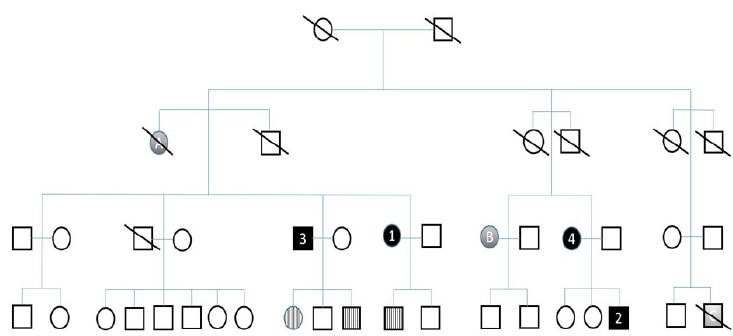
Figure 3. Pedigree of a family with frontotemporal dementia. Cross ‐ hatched symbols represents individuals who are no longer living. Black circles (females) and squares (males) represent individuals with dementia (1,2,3,4). Symbols with colour gradients represent patients with a positive history of dementia without genetic testing (A,B,C). Symptomless individuals who are mutation carriers are in the pattern 4. Discussion Proper clinical differentiation between fvAD and bvFTD has implications for prog ‐ nosis, treatment, and caregiver burden. Unfortunately, the clinical presentation in the course of bvFTD and fvAD can be very similar. FvAD is characterized by episodic memory impairment accompanied by behavioural and/or executive function deficits [6]. The clinical course of FvAD is less well defined, coming mainly from case reports. Our patients’ history and additional testing first suggested fvAD (dysexecutive type), but extended genetic testing eventually revealed another cause of dementia. After receiv ‐ ing the NGS results, we asked ourselves whether it was possible to make a correct clinical diagnosis based on the data available so far. Both patients did not meet the diagnostic criteria for bvFTD, which include a wide range of neuropsychiatric behaviours (disinhibited behavior, profound apathy, loss of em ‐ pathy, perseverative/compulsive behaviour, hyperorality or dietary changes) [9]. In both patients, the leading clinical feature was cognitive decline (episodic memory deficit, im ‐ paired learning of new information, and executive deficits). Atypical clinical presentation is more common in early ‐ onset AD (EOAD). Apathy, which was the only neuropsychiatric disorder, is widespread in AD patients. Furthermore, in early dementia, memory impair ‐ ment and executive deficits may be more common than behavioural changes. Symptoms of dementia appeared in both patients before the age of 60 years, but in the mother of Case 2, at the age of 80 years, with episodic memory deficit initially present. Unfortunately, the age of onset of symptoms does not differentiate FTD from AD. Of all AD patients, approximately 10% are diagnosed with EOAD, with symptoms first appear ‐ ing between the age of 30 to 65 years. EOAD is an almost entirely genetically determined disease, mutation determines disease onset in most families, but rare, high ‐ penetrance mutations in APP , PSEN1 , and PSEN2 genes explain only a small percentage of families with EOAD, leaving a large group of autosomal dominant pedigrees genetically unex ‐ plained [10]. Age of onset in genetic forms of FTD is also highly variable, but unlike EOAD, with advanced within ‐ family variability [11]. It was been shown that frontal ‐ parietal cortical areas are involved in neuroimaging studies in AD patients more often than in patients with typical AD, but less often than in patients with bvFTD [4]. In our patients, we observed small fronto ‐ parietal atrophy with widening of Sylvian fissure. Temporal horns dilatations and white matter hyperintensity (T2 ‐ weighted MR) were present on MR of Case 2. White matter abnormalities and